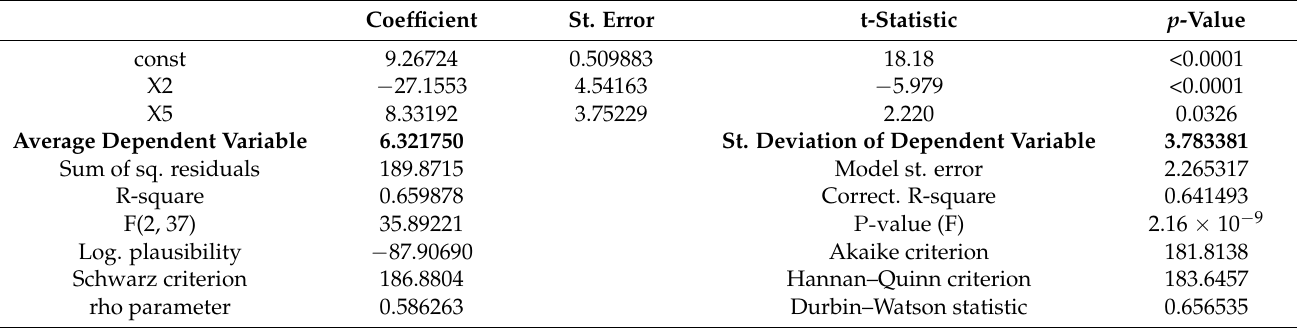
Table 16. Regression model 2 statistics.